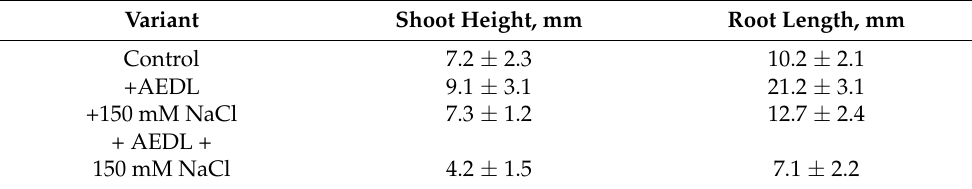
Figure 1. Twenty-eight days of tobacco seedling growth without and with additives. Table 1. The height and length of tobacco seedlings grown under different conditions.